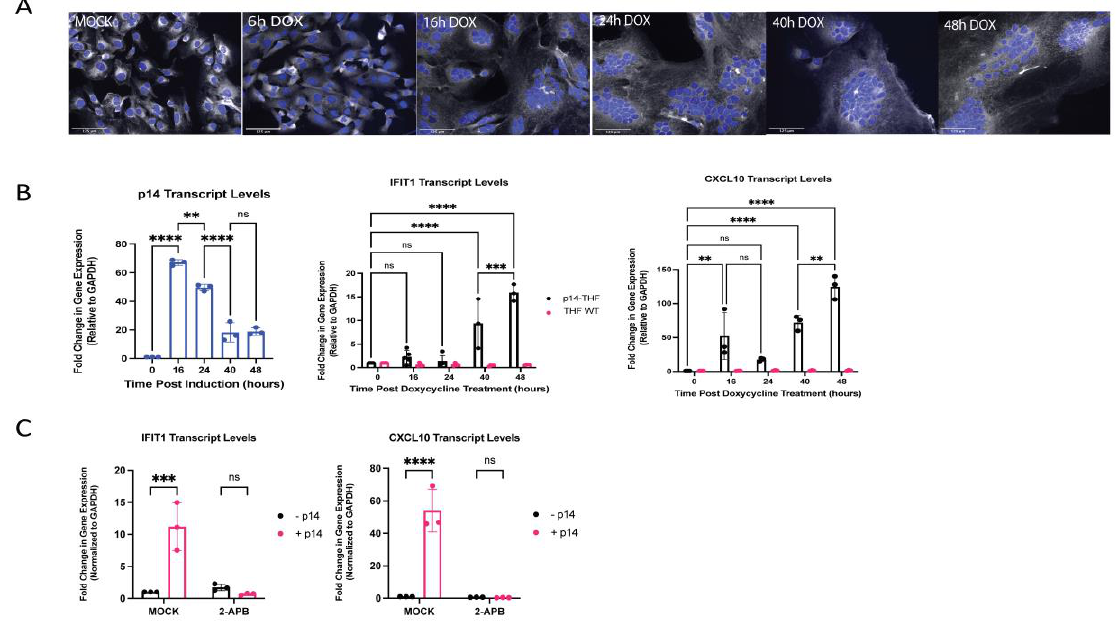
Figure 5. Endogenous expression of p14 triggers cell-cell fusion and an antiviral response in a Ca 2+ - dependent manner. THF-p14 cells were treated with 0.01 µ g/mL of doxycycline and monitored over a 48 h time period. ( A ) Cell nuclei were stained with Hoechst 33,342 (blue), and cell membranes were stained with CellMask Deep Red (white). Scale bar indicates a size of 125 µ m. ( B ) The presence of p14 in the cells upon doxycycline treatment was verified by RT-qPCR. ( B ) The levels of ISG expression in wildtype THF and p14-THF cells treated with 0.01 µg/mL of doxycycline were assessed by RT-qPCR from RNA harvested at various time points over a 48 h time course. The transcript levels were normalized to GAPDH level and plotted relative to those in uninduced (Time 0 h) cells. Groups were compared by one-way ANOVA (** for p < 0.01, *** for p < 0.001 and **** for p < 0.0001). ( C ) THF-p14 cells were treated with 0.01 µ g/mL of doxycycline for 6 h, then treated with 200 µ M 2-APB to block calcium release from the ER, and the ISG transcript levels were measured after 48